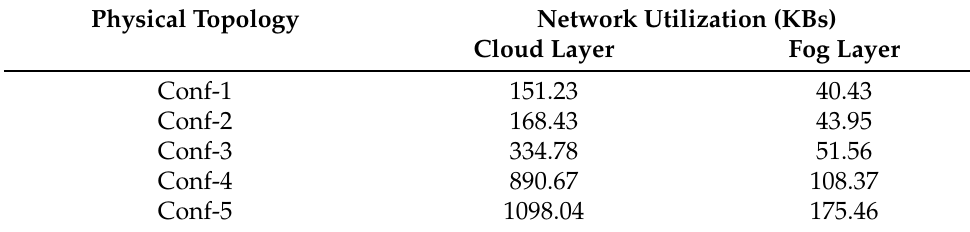
Table 7. Comparison of network